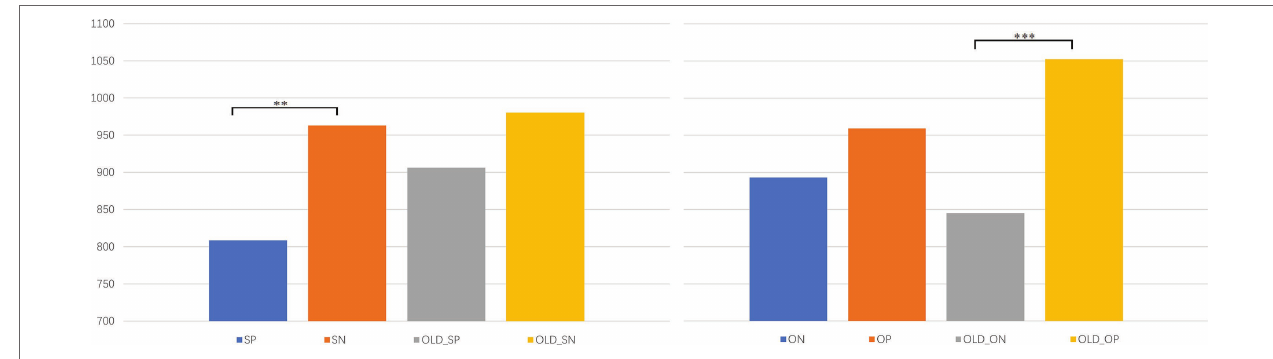
FIGURE 3 | The mean reaction times of the self-face and friend-face associated with positive and negative words in the present and old face conditions. SP refers to self-positive; SN refers to self-negative; OP refers to other-positive; ON refers to other-negative; OLD refers to stimuli in old condition. The two kinds of faces showed different patterns. ** p < 0.01; *** p <